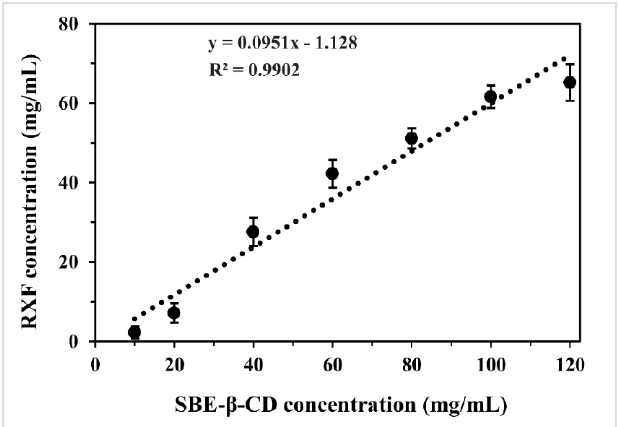
Figure 1. Phase solubility diagram plotted with dissolved raloxifene (RXF) vs. different concentrations of SBE-β-CD in water.